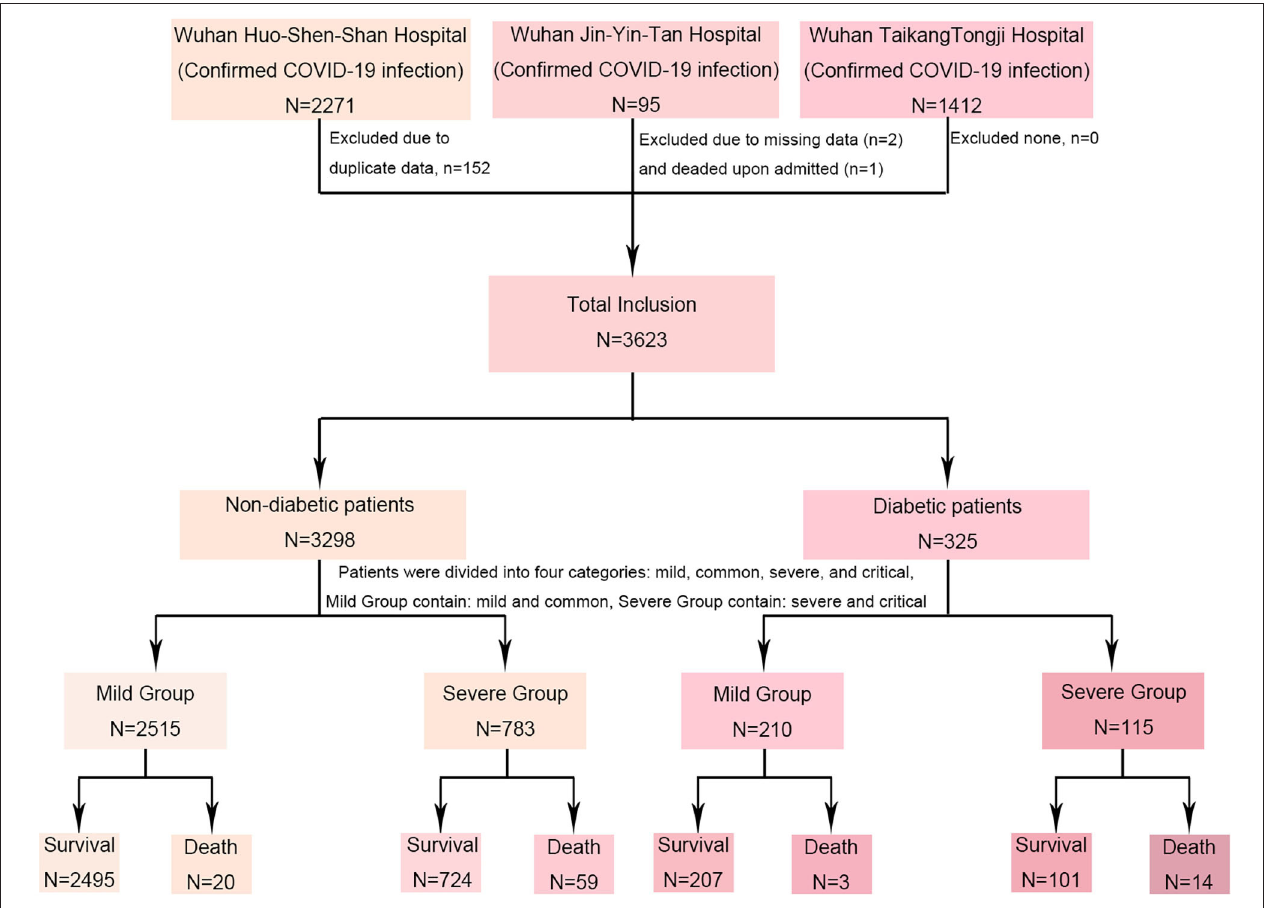
FIGURE 1 | Enrollment flow chart of study